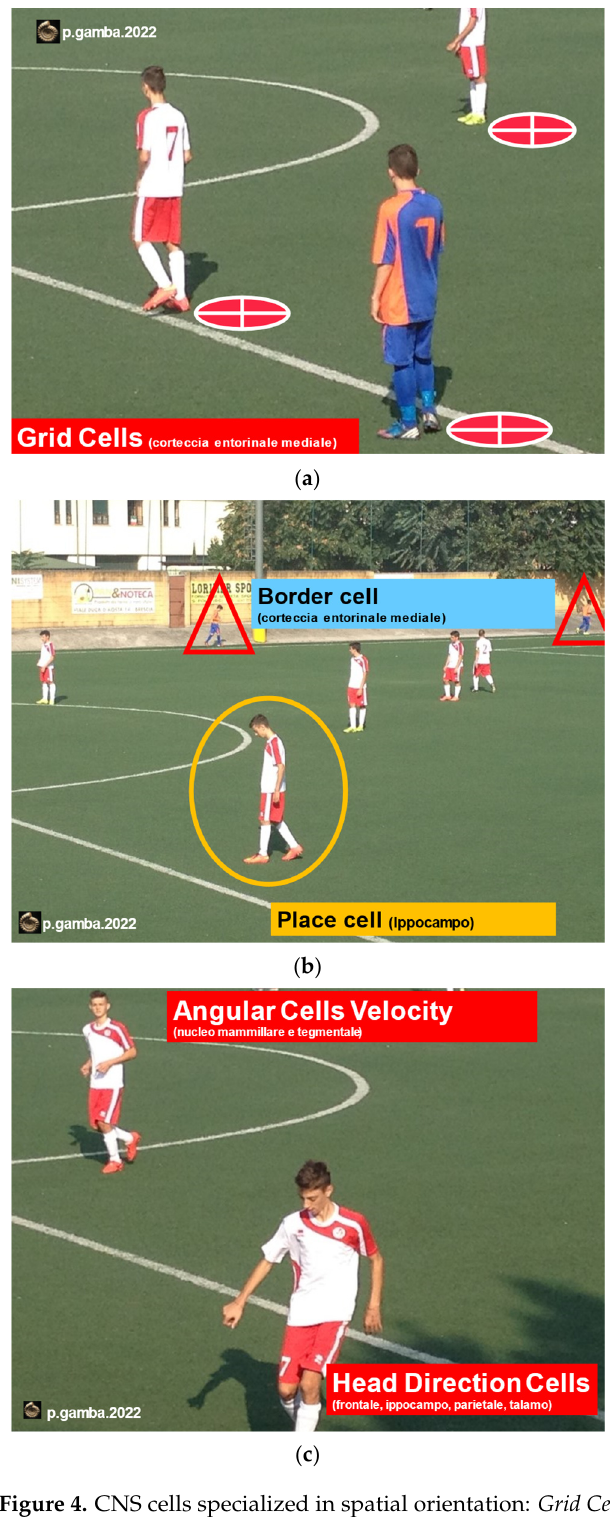
Figure 4. CNS cells specialized in spatial orientation: Grid Cells and the Border Cells , located in the medial entorhinal cortex ( a ); Place Cells , located in the hippocampus ( b ); Head Direction Cells (HD), located in the frontal cortex, in the hippocampus, parietal cortex, and thalamus, and indicate the direction of the head; the Angular Velocity Cells (AVC), located in the mammillary and tegmental nucleus and indicate the speed of rotation of the head ( c